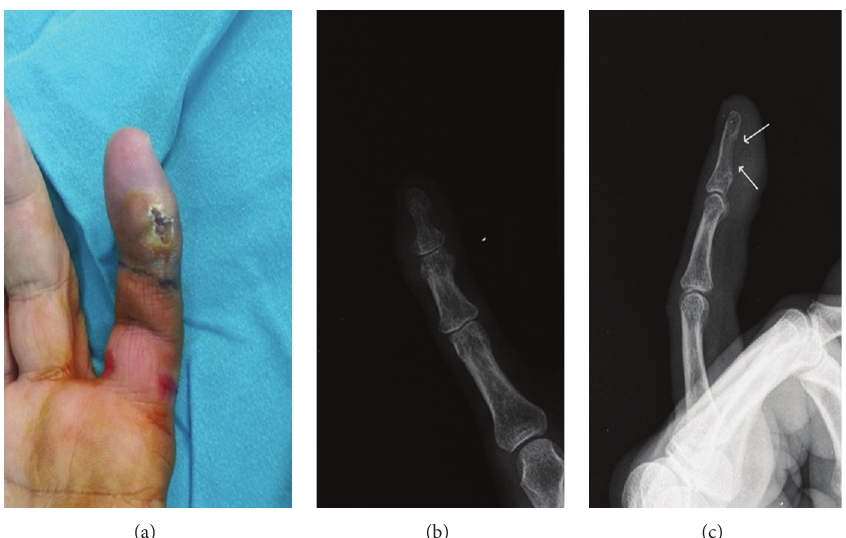
Figure 4: (a) Painful ulcerated lesion on the finger pulp on the left hand’s small finger. ((b), (c)) PA and lateral radiographs. (c) Arrows in cortical bone and soft tissue increased radiolucent areas.